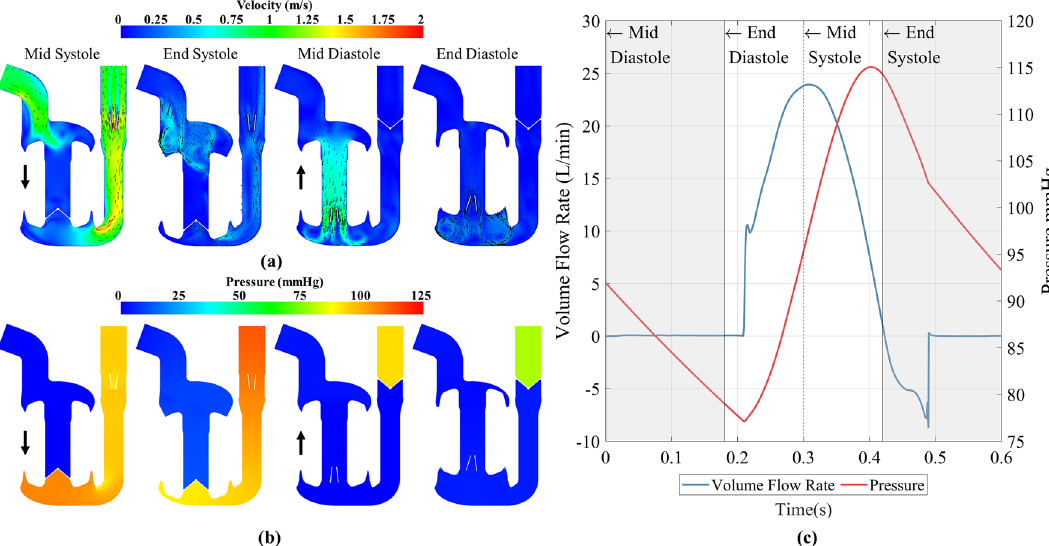
Figure 3. ( a ) Velocity flow field and ( b ) pressure contour plots at mid systole, end systole, mid diastole and end diastole at an operating point of 100 bpm 21 mm, equating to 5 L/min. Black arrows at mid systole and mid diastole denote direction of the AV plane. ( c ) Transient outlet volume flow rate and outlet pressure. Grey regions of plot denote diastole whilst white regions are